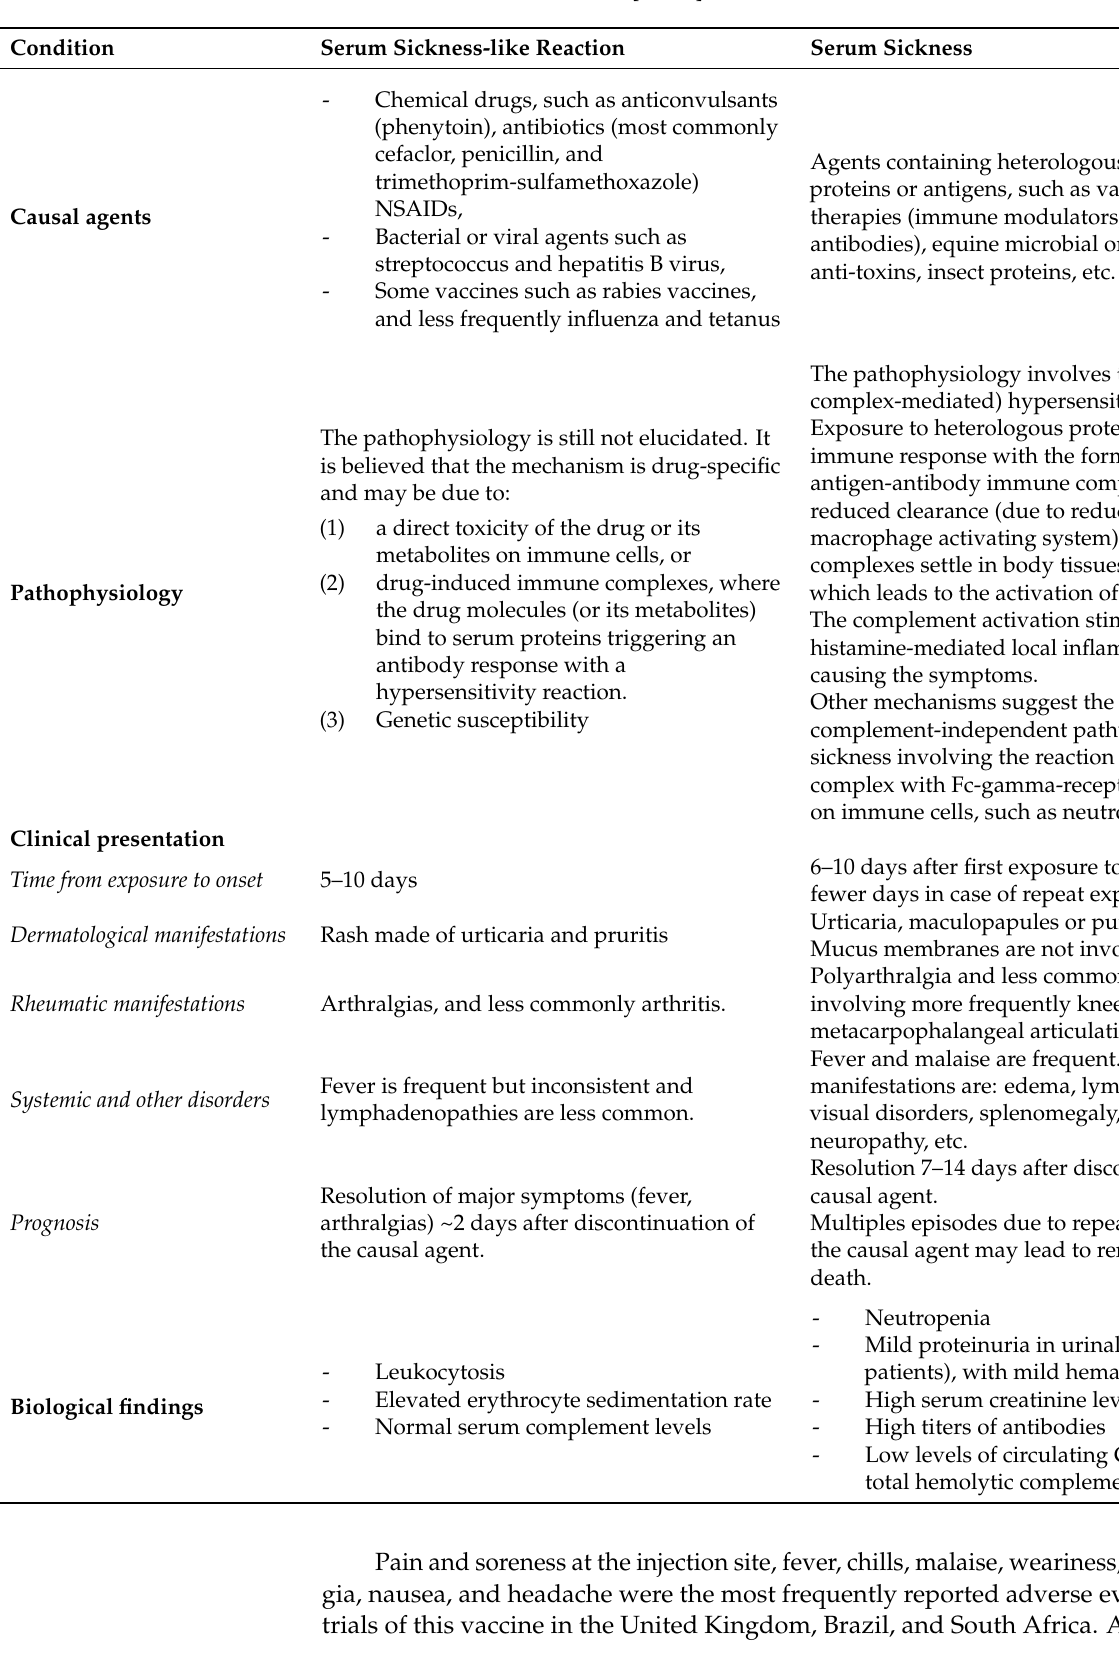
Table 1. Comparison of the clinical and pathophysiological characteristics of serum sickness-like reaction versus serum sickness